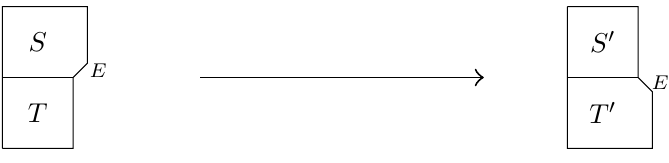
Figure 4 . A flop transition that corresponds to changing the chamber of Coulomb branch. S ′ is a blow-down of S and T ′ is a blow-up of T